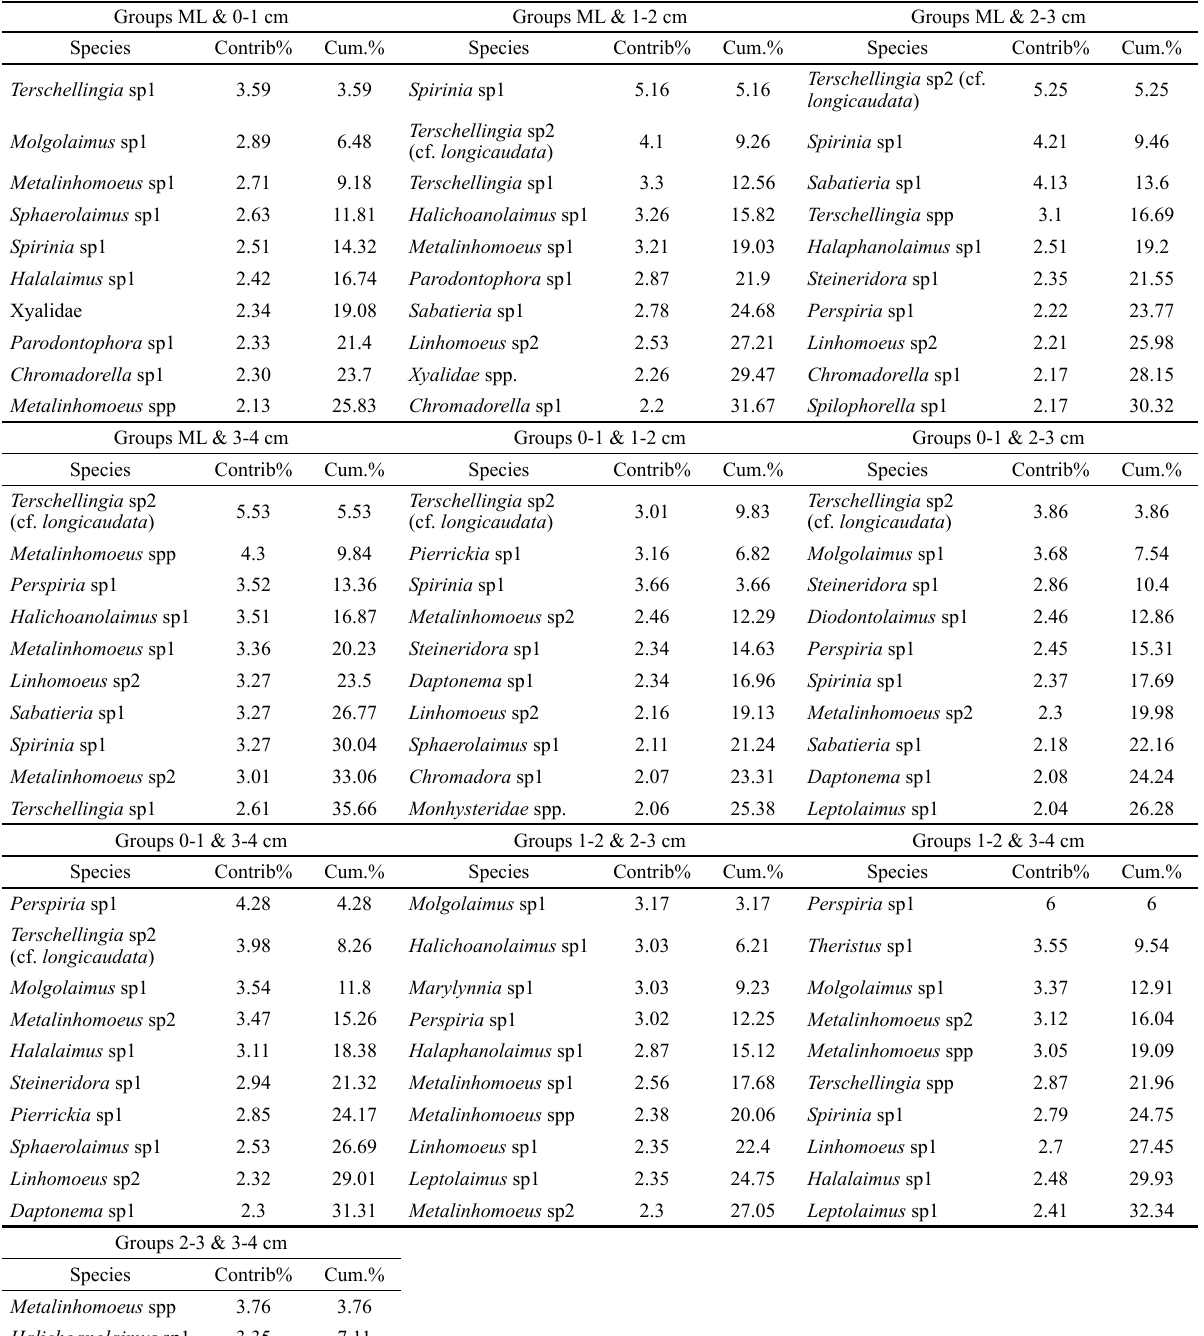
Table S5. – SIMPER analysis showing the contribution of nematode species to between-layer dissimilarity. The ten most contributing taxa are reported. The following abbreviations were used: Contrib.%, contribution%; Cum.%, cumulative